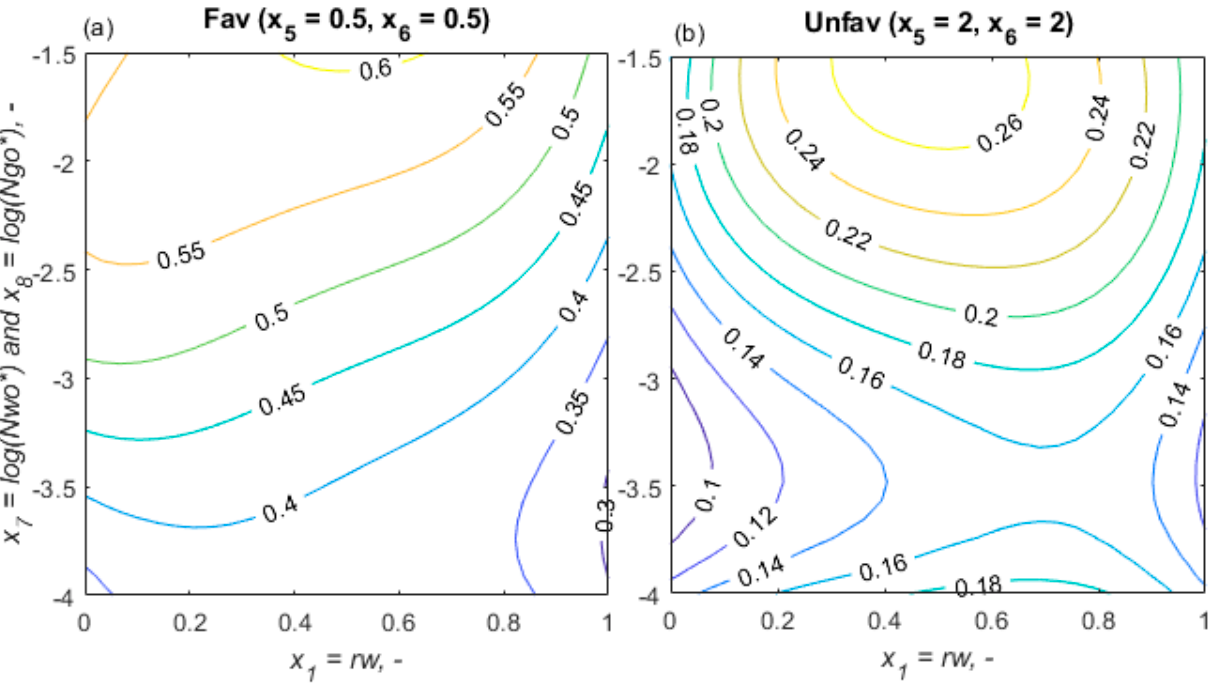
Figure 12. Contour plot of recovery factor RF plotted against x 1 = r w and log gravity number with equal values of x 7 and x 8 . Favorable ( a ) and unfavorable ( b ) mobility ratio cases are shown (see all input values in Table 6).